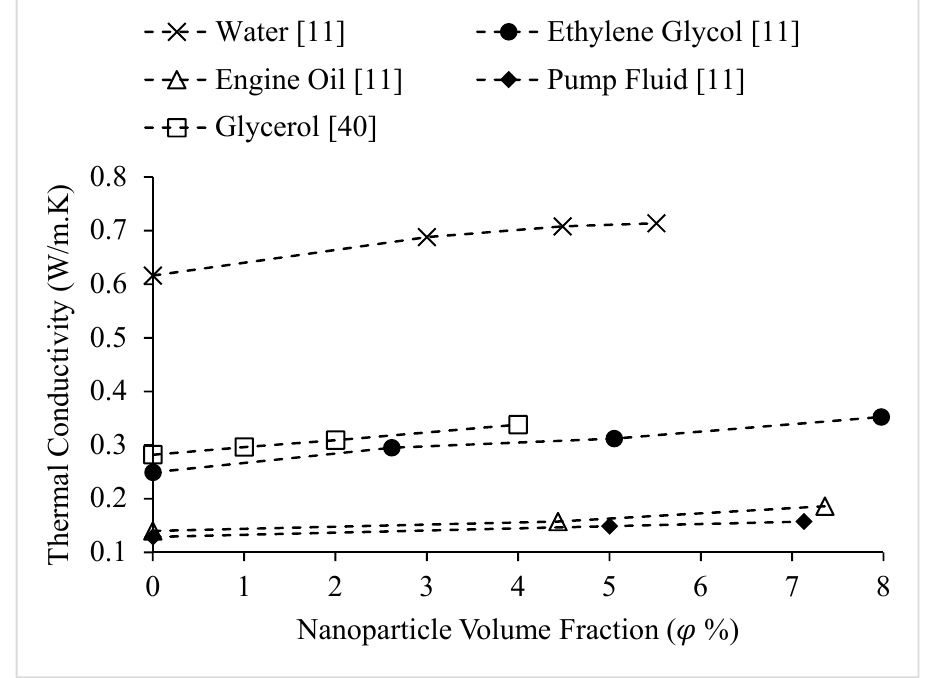
Figure 15. Variation of alumina nanofluid thermal conductivity as a function of nanoparticle volume fraction, 𝜑 , for different base liquids, at room temperature.